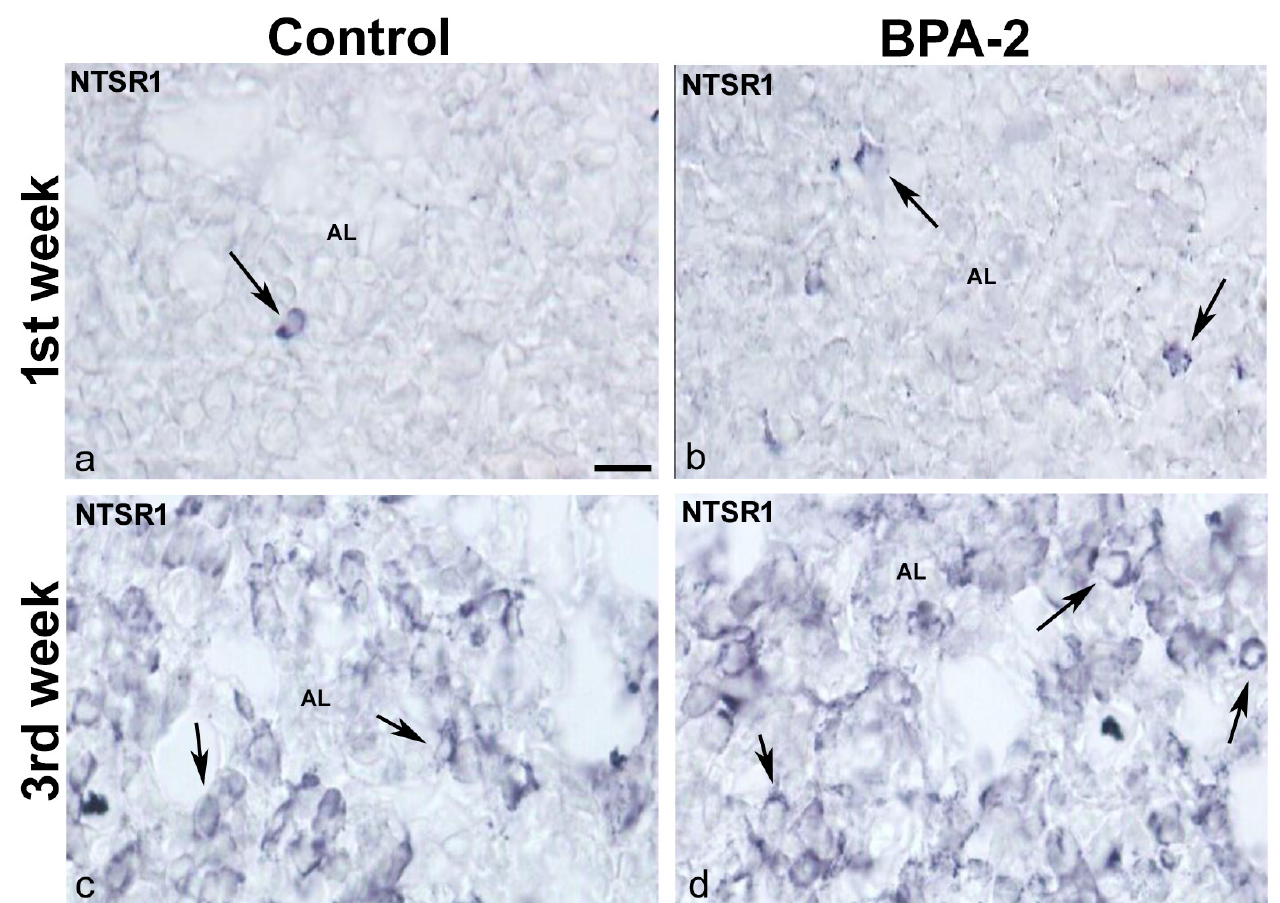
Figure 5. NTSR1 immunoreactivity in the offspring pituitary gland. Representative images of the pituitary gland in the first ( a , b ) and third ( c , d ) weeks of postnatal life showing the presence of NTSR1-ir cells (arrows) in the central area of the anterior lobe in the control and BPA-2 groups. AL: anterior lobe. Scale bar: 25 µm.